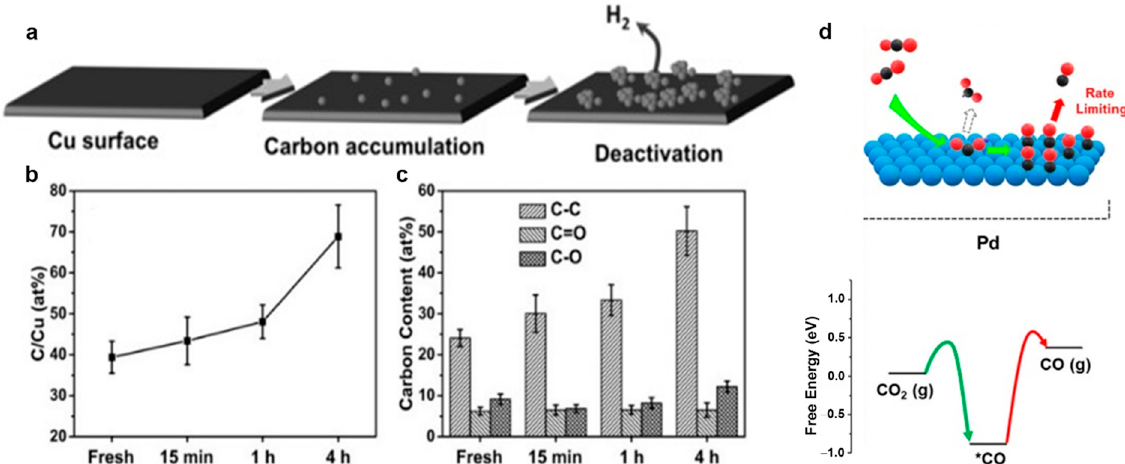
Figure 9. Catalyst deactivation mechanism by poisoning: ( a ) schematic diagrams showing carbon accumulation on a copper catalyst surface; ( b ) the calculated C/Cu ratios on the catalyst surface after electrochemical carbon dioxide reduction reaction (CO 2 RR) for various times; ( c ) bar chart indicating the types and relative abundances of carbonaceous bond observed on the catalyst surface after electrochemical CO 2 RR (reproduced with permission from ref. [53], copyright 2017, WILEY-VCH); ( d ) schematic illustration of the CO poisoning of a Pd electrocatalyst due to the strong binding (large desorption energy barrier) of CO (reproduced with permission from ref. [54], copyright 2019, ACS).